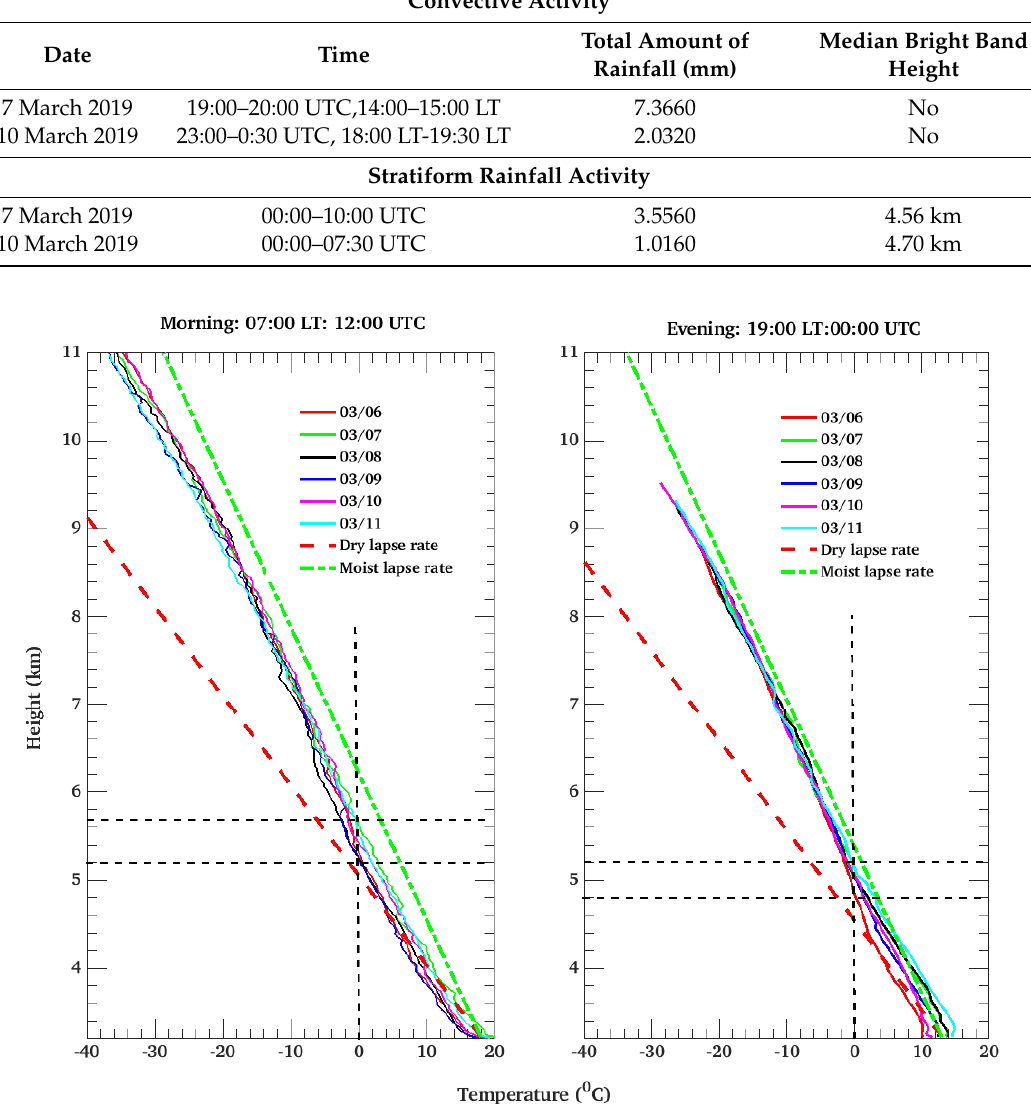
Figure 9. Vertical temperature profiles during rainy periods recorded by radiosonde launches in 6 March to 11 March at the site of the Huancayo. Representative moist and dry adiabatic lapse rates are indicated by the long and short-dashed lines, respectively.